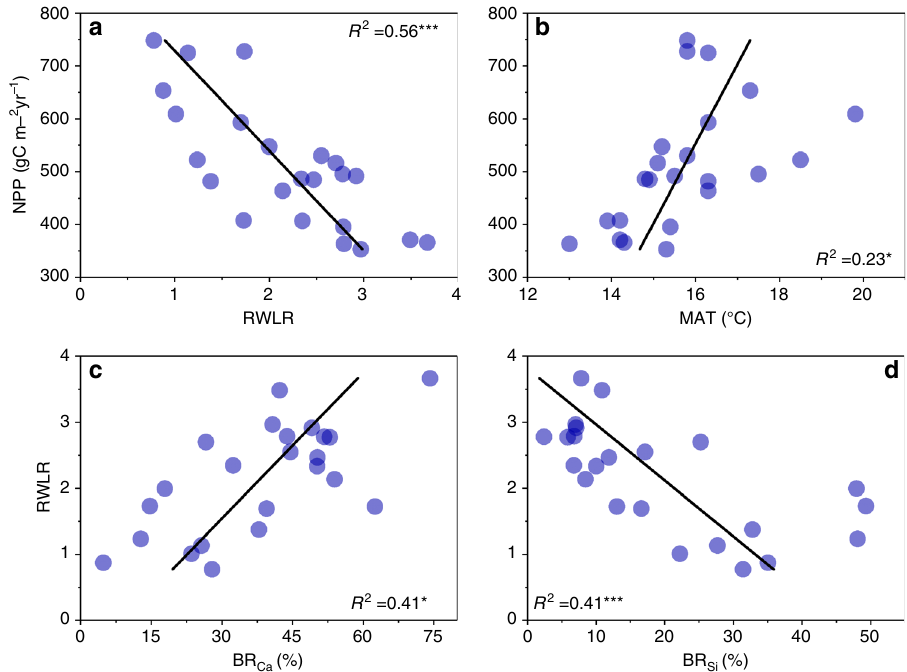
Fig. 3 Linkages between NPP and predictor variables. Relationships between NPP and a regolith water loss rate (RWLR), b mean annual temperature (MAT); the relationships between RWLR and: c bedrock calcium oxide content (BR Ca ), and d bedrock silicon oxide content BR Si . Adjusted R -squared ( R 2 ) and levels of signi fi cance are shown (* p < 0.05, ** p < 0.01, *** p < 0.001).